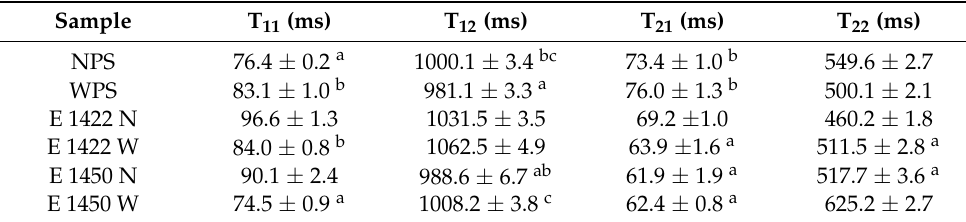
Table 4. Relaxation times of model emulsions made with aerogels.